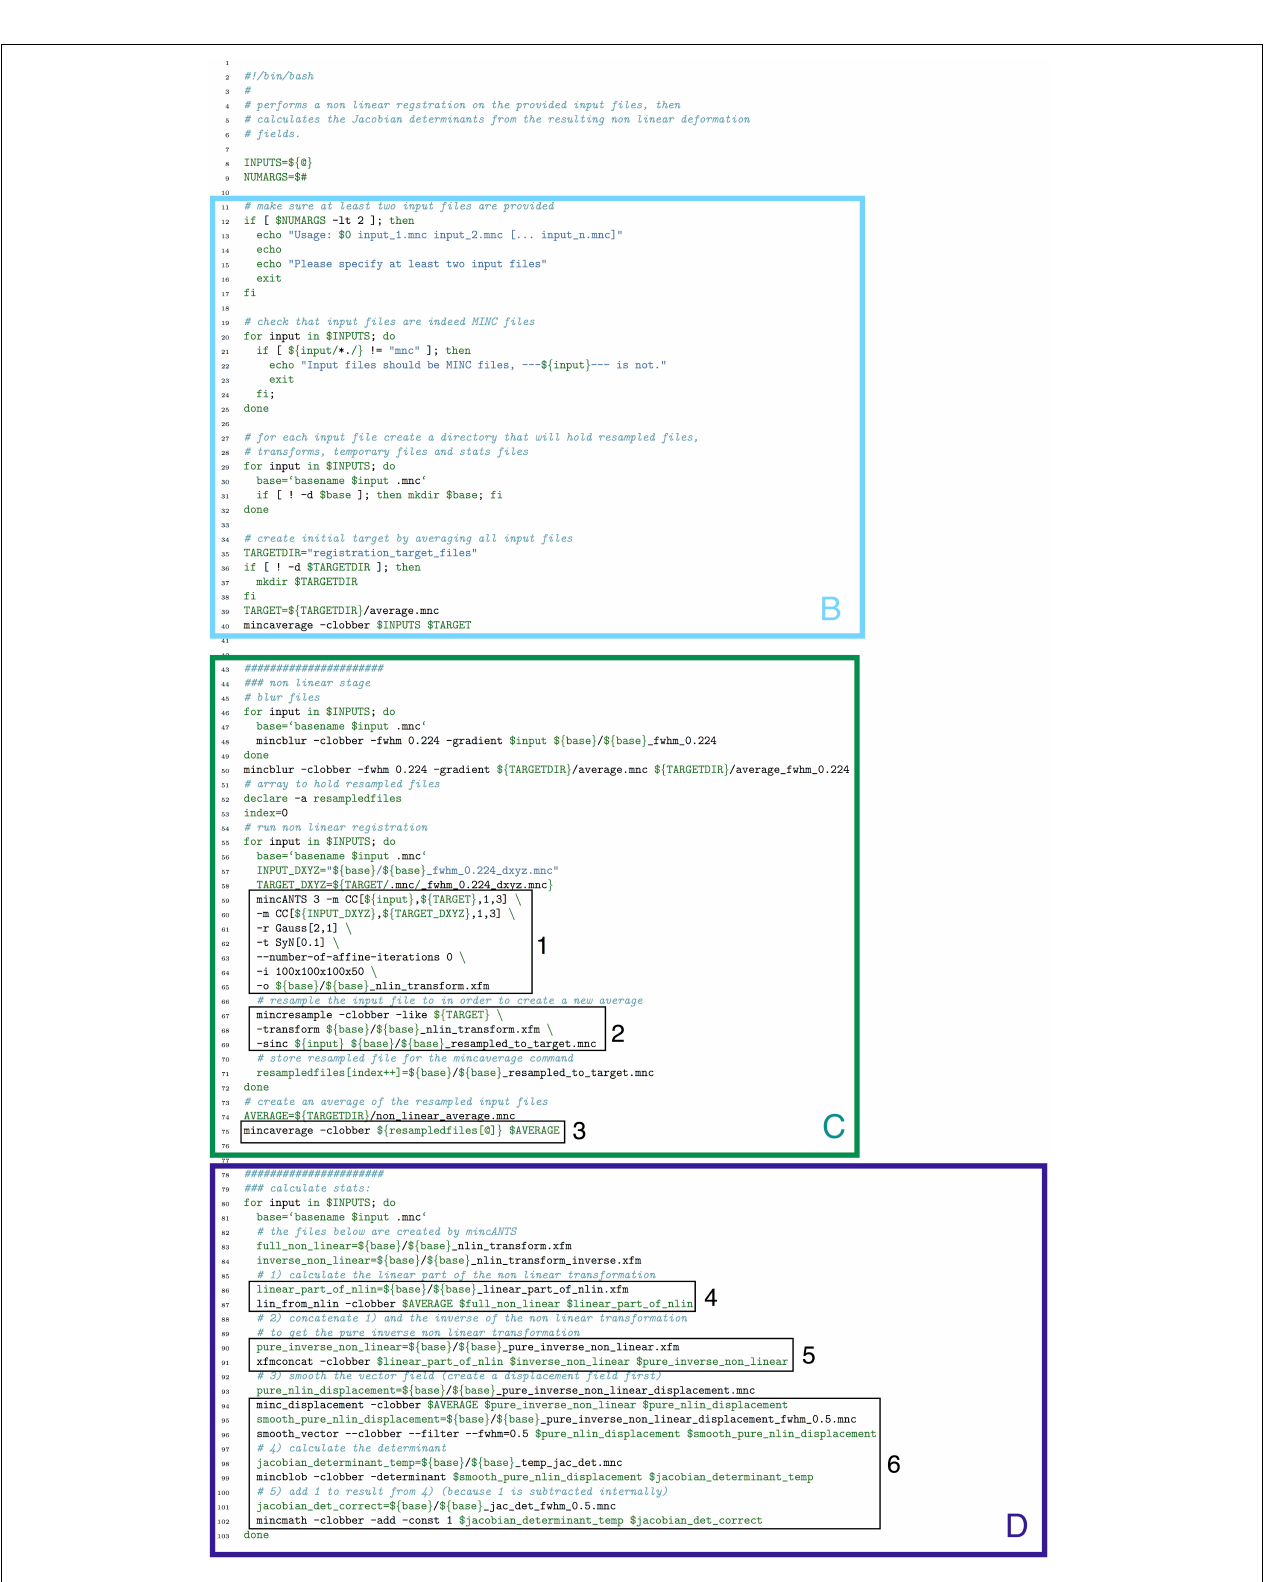
FIGURE 13 | Bash script that does a non-linear alignment from a set of inputs to a common target, then calculates the resulting deformation fields and their Jacobian determinants. Note that our